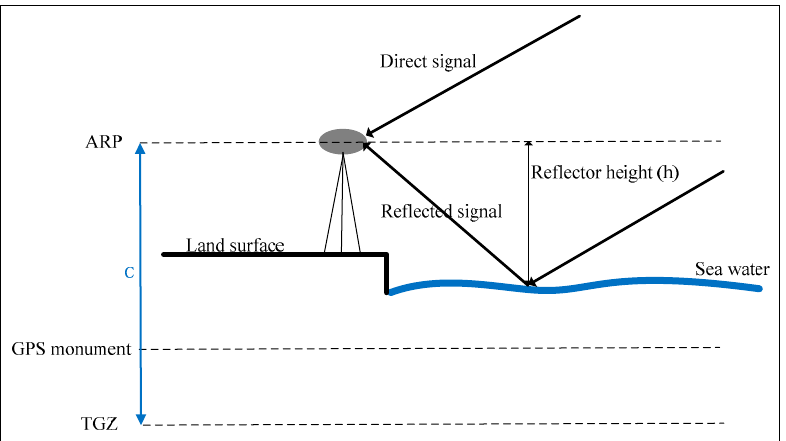
Figure 1. Simplified schematic diagram of the ground-based global navigation satellite system reflectometry (GNSS-R) altimetry system with one antenna and the multi-path effect of direct and reflected signals. Definitions: ARP, antenna reference point; GPS, global positioning system. TGZ: tide gauge zero.